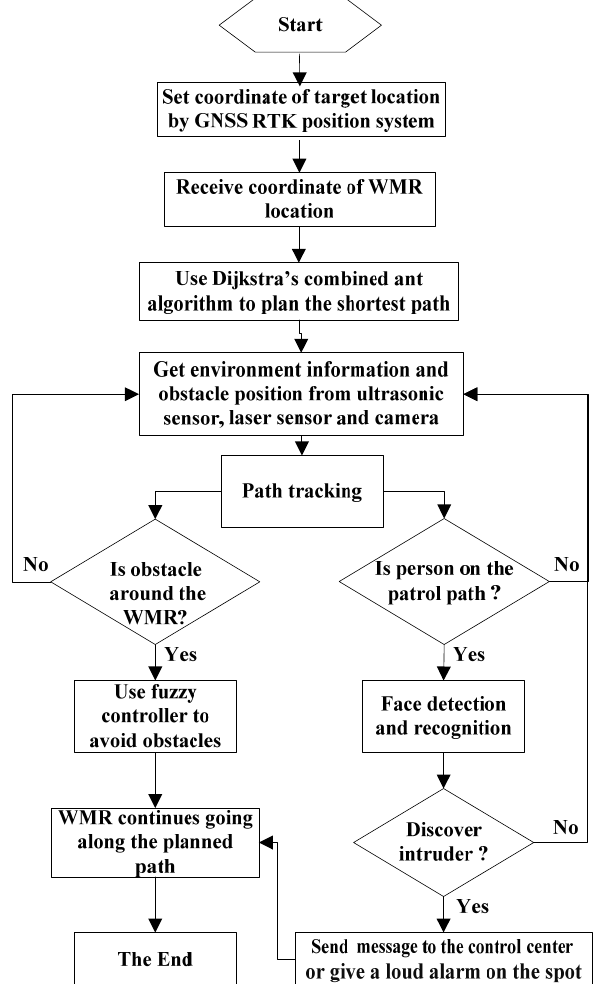
Figure 20. Flowchart of the control sequence.